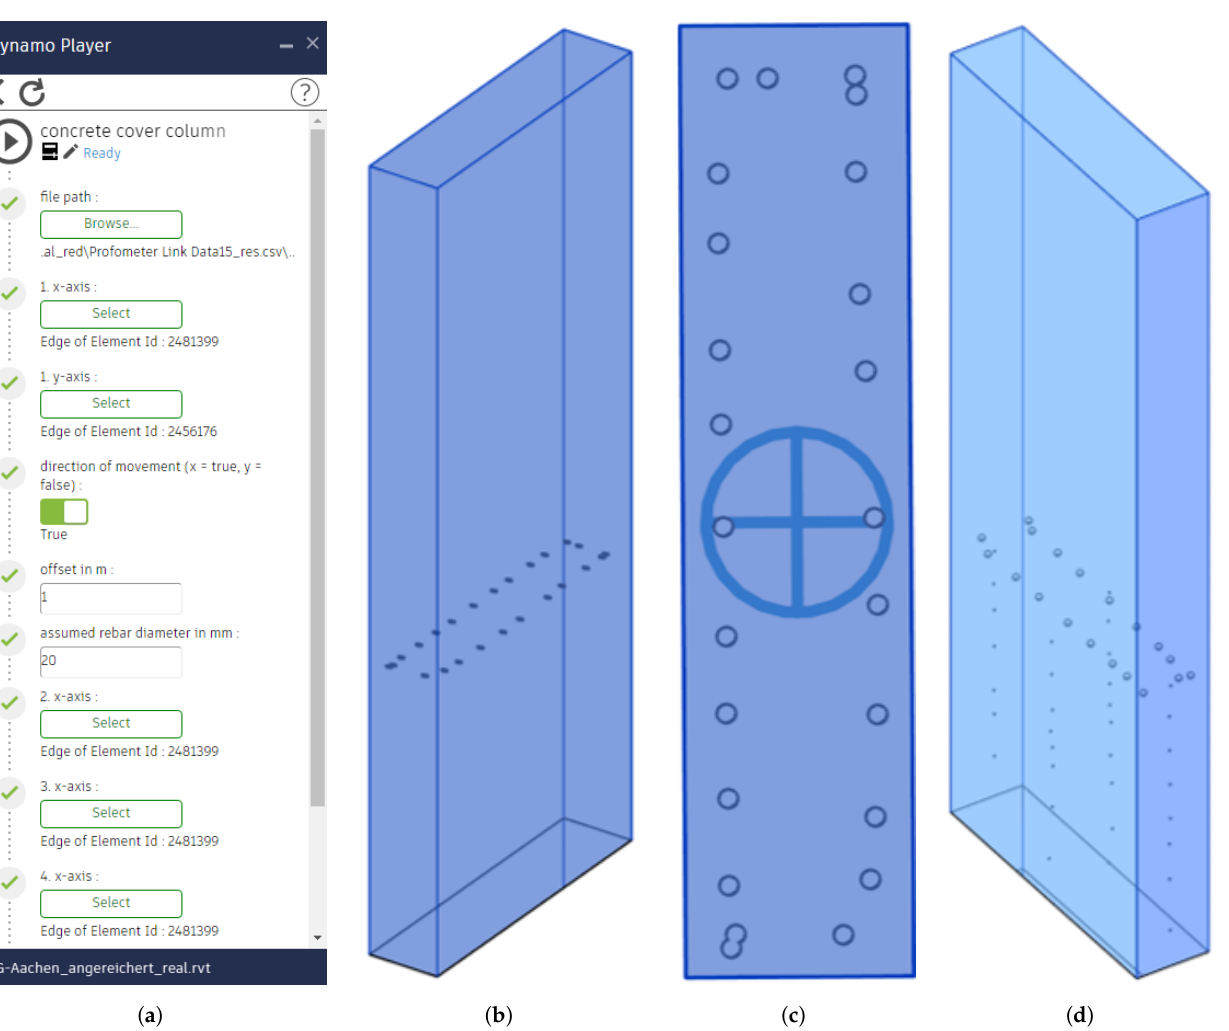
Figure 3. ( a ) GUI of the Dynamo Player; ( b ) implementation of horizontal concrete cover measure- ments; ( c ) top view of concrete cover of vertical rebars; ( d ) implementation of vertical concrete cover